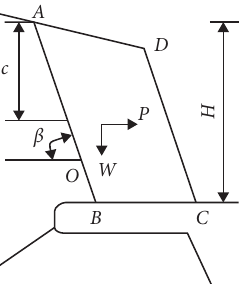
Figure 13: Calculation model for the unstable falling-type rock.